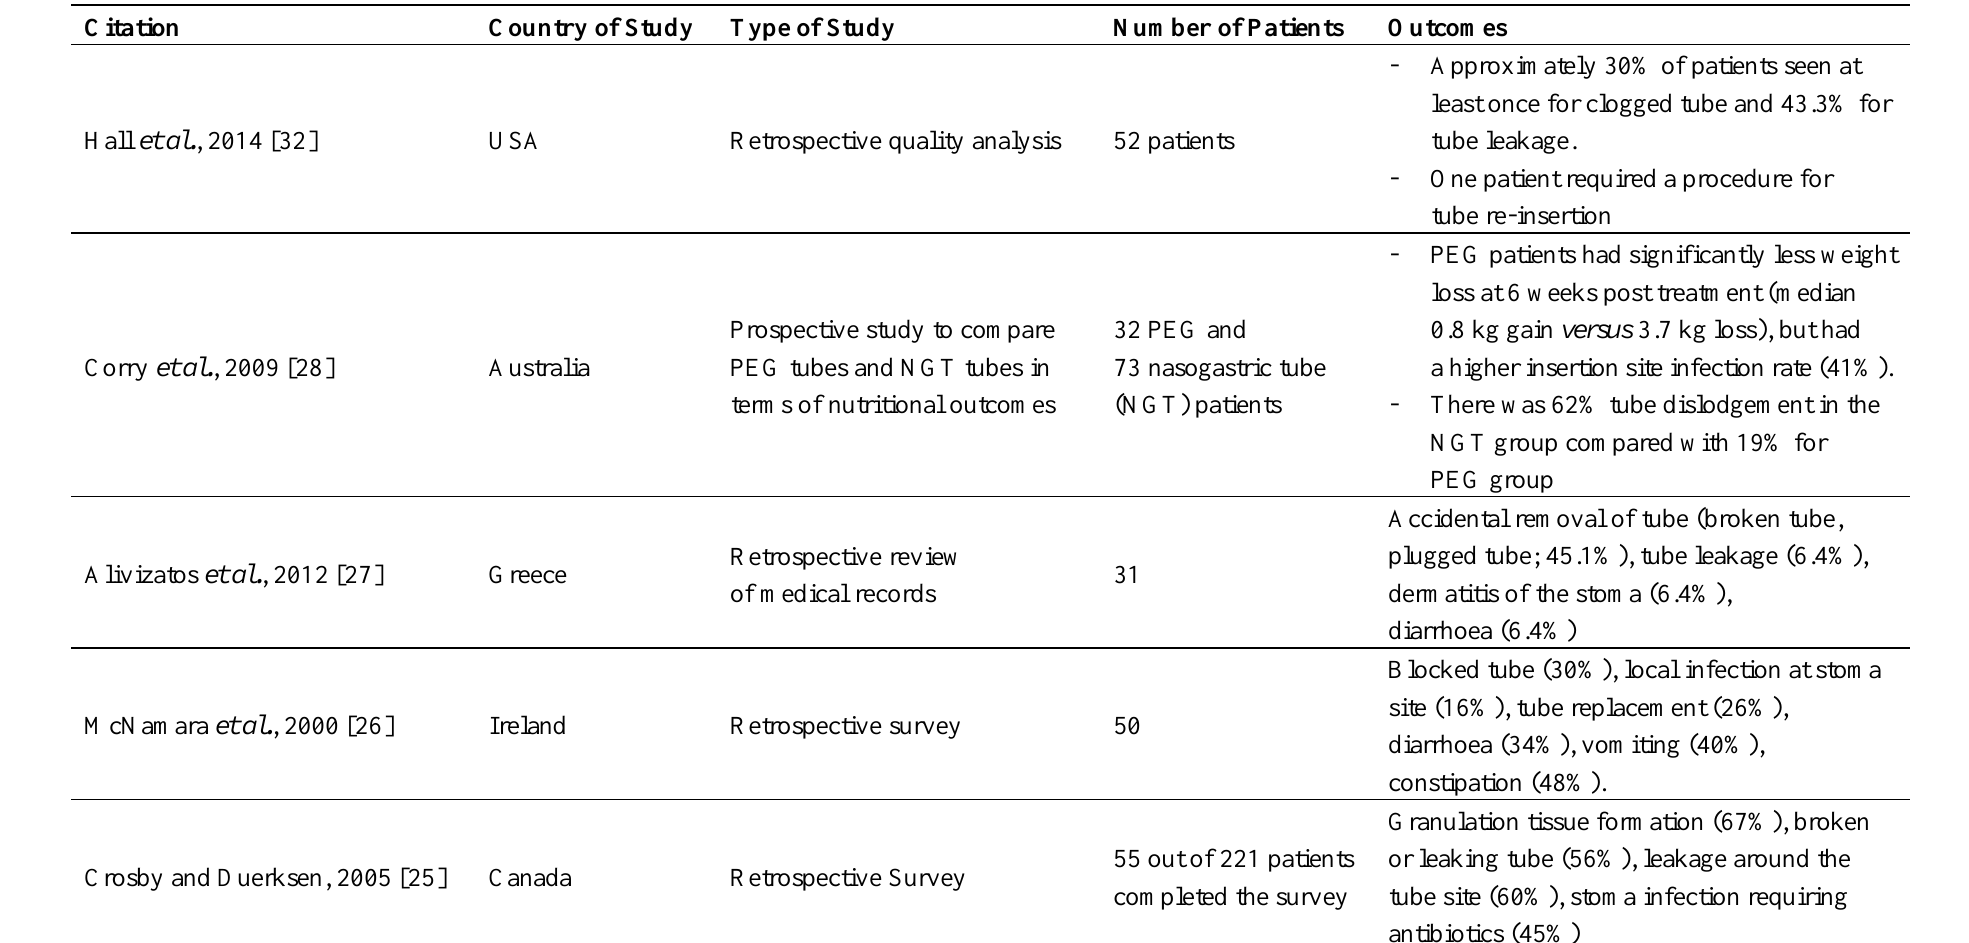
Table 1. Incidence of Enteral Feeding